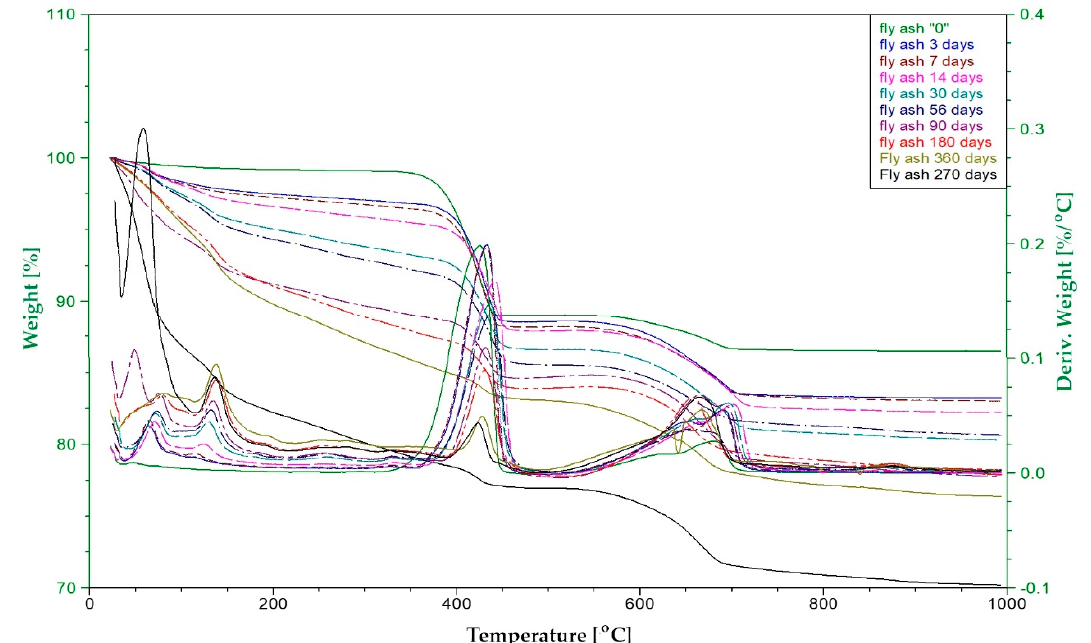
Figure 8. TG and DTA thermogram of fly ash / Ca(OH) 2 samples after di ff erent periods of curing.